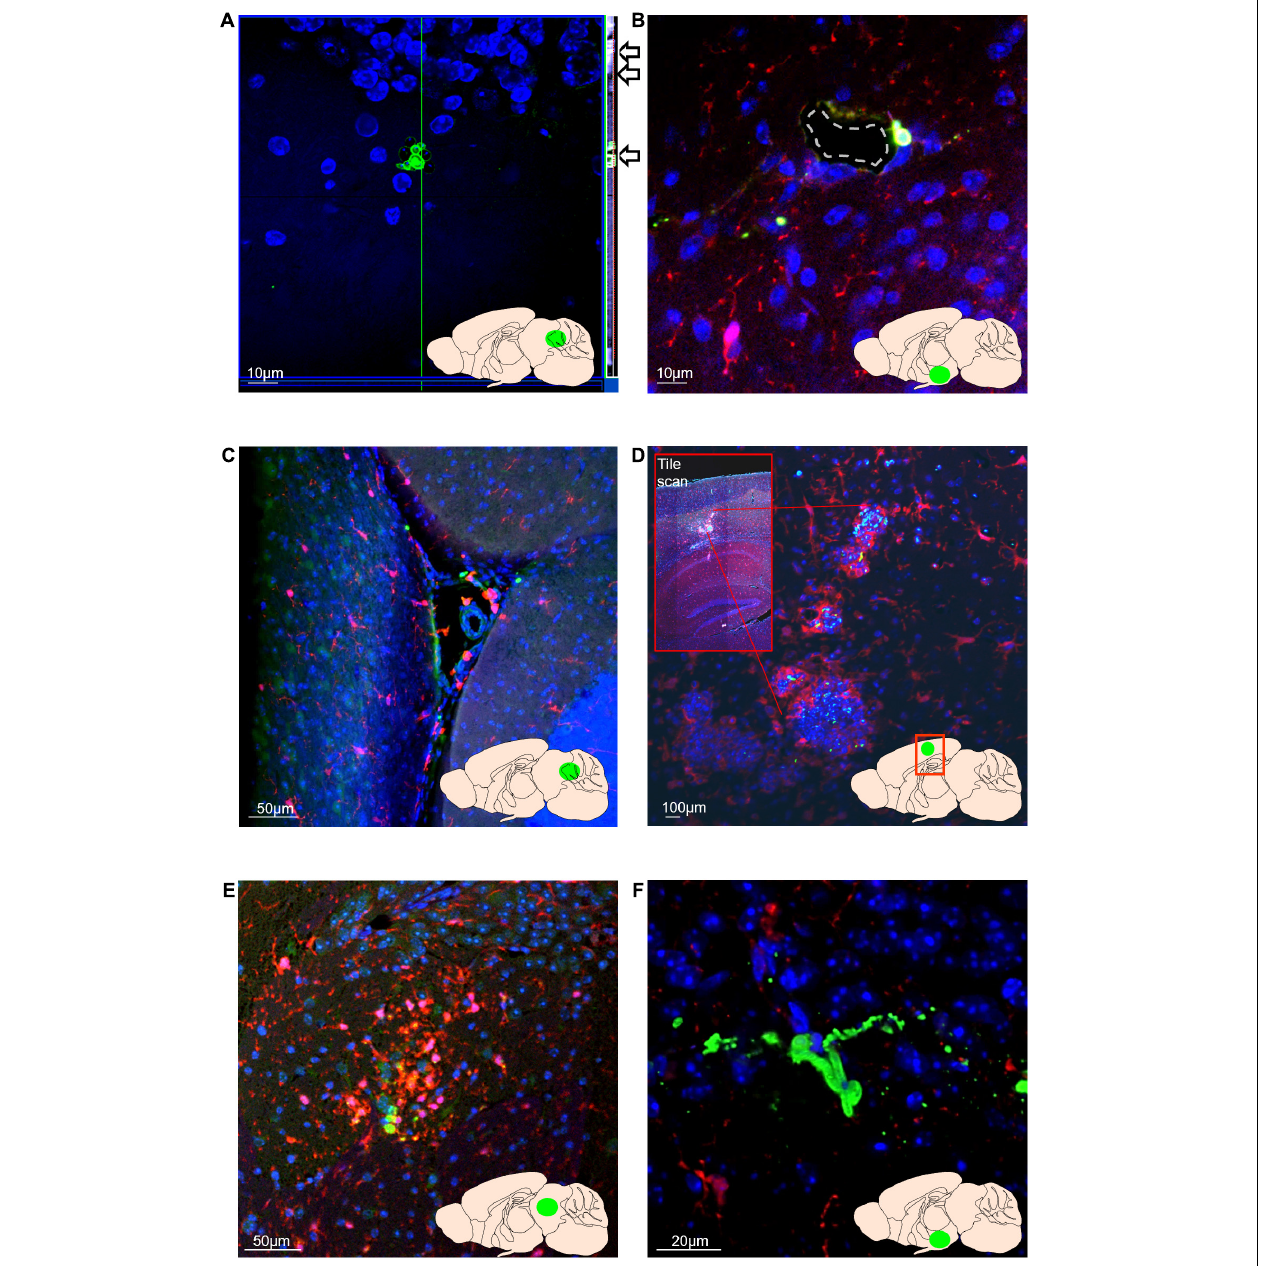
FIGURE 3 | Candida albicans can disseminate from the gut to the brain and can grow in the invasive hyphal form within brain tissue. In all images, blue = nuclei (Hoechst), green = C. albicans , red = Iba-1-positive microglia/macrophages. Green area in inset brain schematic indicates approximate position of image. (A) C. albicans cells are detectable within cerebellar brain tissue at 5 days post-colonisation. Z-stack orthogonal view (side bar and arrows) shows C. albicans cells are in the same plane as brain cell nuclei. Orthogonal side bar brightness and contrast has been enhanced here for visibility. (B) C. albicans cells in proximity to a hypothalamic blood vessel (dashed outline). (C) C. albicans cells and Iba-1 positive macrophages within the cerebral aqueduct (lobule II granule layer visible as dense Hoechst-stained area bottom right of image). (D) Foci of clustered Iba-1 + cells (red) around C. albicans cells (green) within the posterior parietal association area of the cortex. Inset box shows overview tile scan of the cortex and hippocampus. (E) Cluster of Iba-1 + cells around C. albicans cells within the midbrain (F) Entwined hyphal C. albicans hyphae within the hypothalamus.